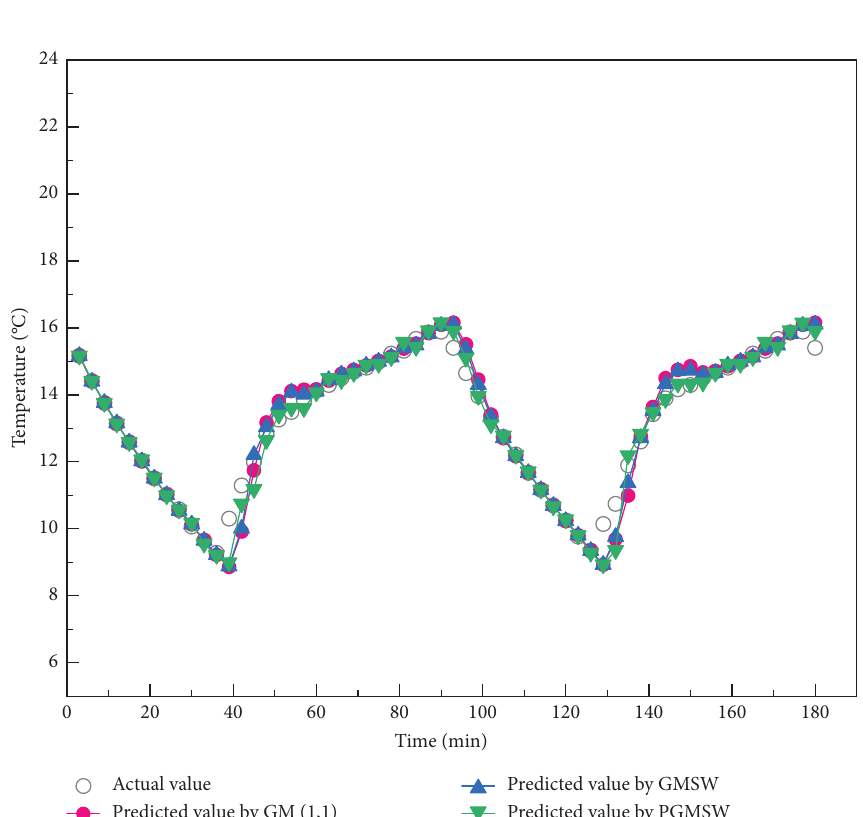
Figure 4: Comparison of three models for predicting SR temperature data (window size �